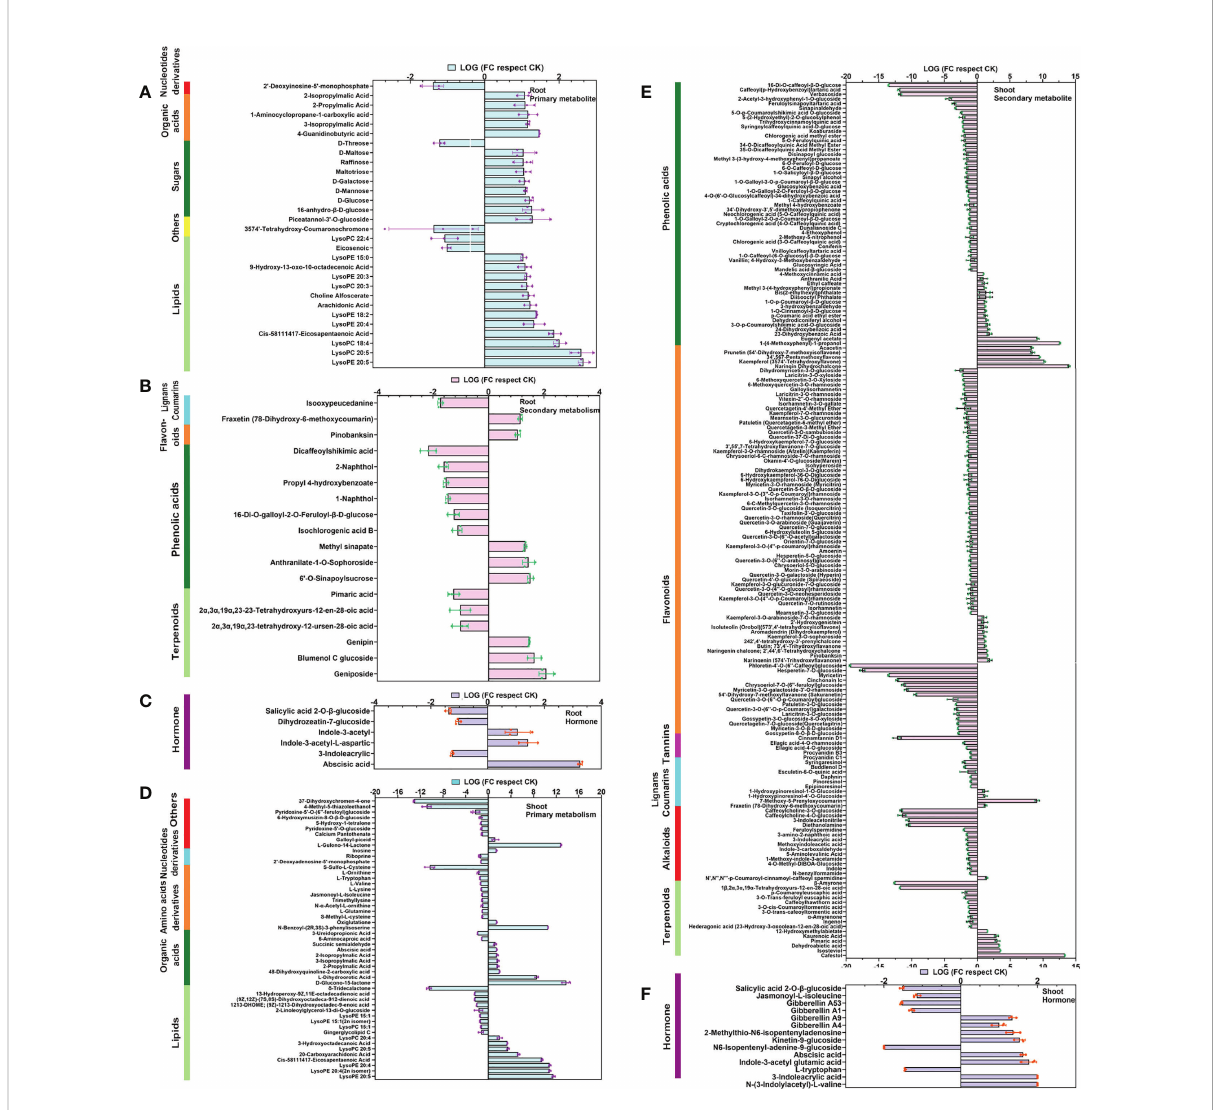
FIGURE 2 Heatmap of differential metabolites in roots and shoots of apple plants inoculated with R . irregularis after 60 days, with the baseline set as the level in uninoculated plants. (A) Thirty differential primary metabolites were identi fi ed in roots of apple plants. (B) Eighteen differential secondary metabolites were identi fi ed in roots of apple plants. (C) Six differential hormonal metabolites in roots of apple plants. (D) Fifty-one differential primary metabolites in shoots of apple plants. (E) One hundred eight- fi ve differential secondary metabolites in shoots of apple plants. (F) Fourteen differential hormonal metabolites in shoots of apple plants. Primary and secondary metabolites are shown as the ratio of relative content, while hormone metabolites were the ratio of absolute content. In the case of each hormonal metabolite, the metabolites were only detected in either the uninoculated or inoculated plant, but not in both sample sets, which was considered to be signi fi cantly regulated (|log 2 FC| =